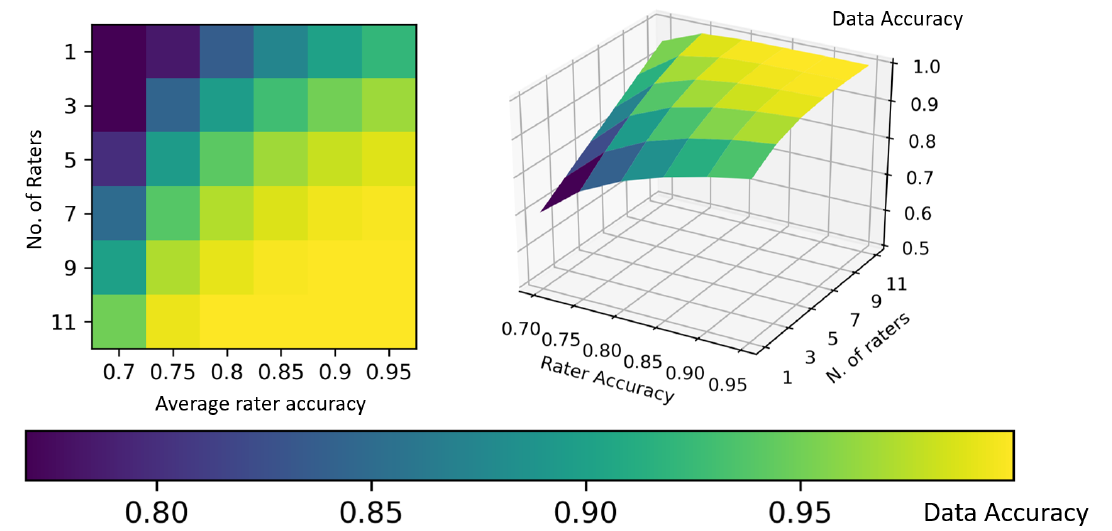
Figure 3. Graphical representation of the relationship between the number of raters involved in any process of ground truthing, their accuracy, and the accuracy of the resulting dataset (by majority voting). Furthermore, these estimates, as in the previous figures, are obtained analytically and hence have general